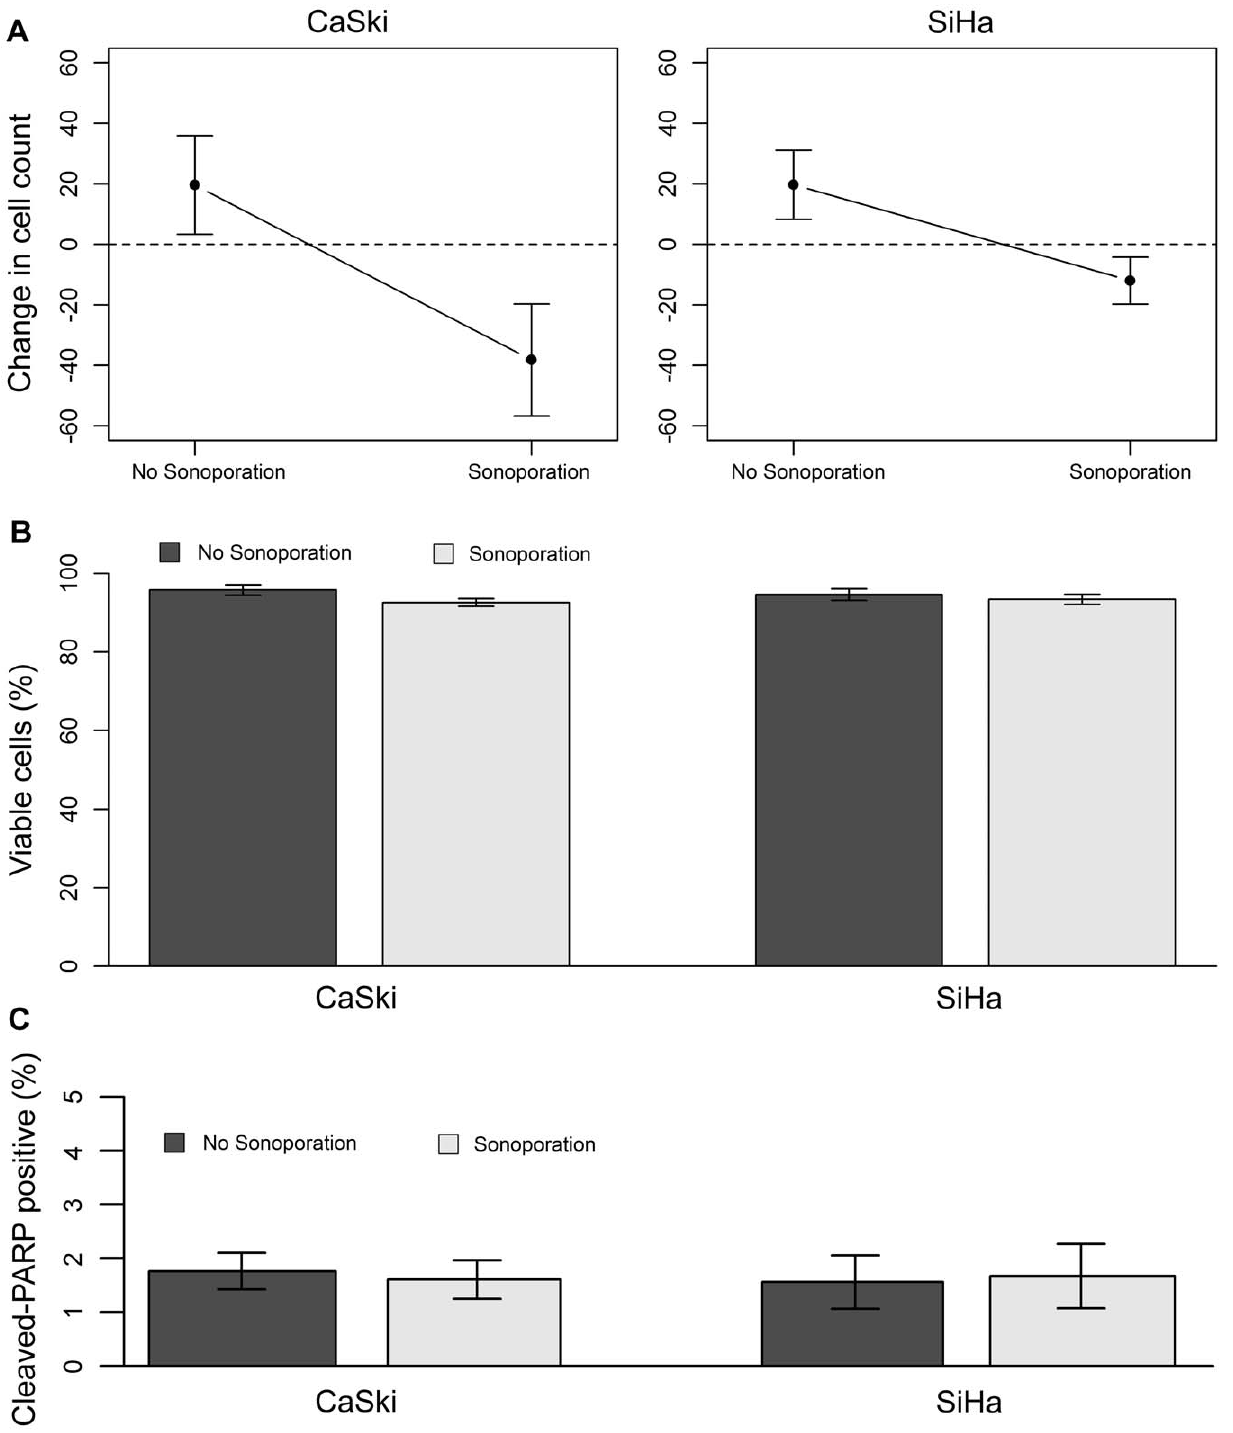
Figure 2. Effects of sonoporation on cell count, viability and apoptosis. (A) Change in cell count 2 hours following exposure of cells to sonoporation or sham no HIFU treatment. Sonoporation had a negative effect on cell count, ( P= 0.003, n= 10). Statistical analysis was performed using a two-way ANOVA with Student’s two-sample t-tests post hoc. (B) Viability of remaining cells 24 hours following exposure of cells to sonoporation or sham no HIFU treatment. Sonoporation did not diminish the viability of the remaining cells ( P . 0.05, n= 10). Statistical analysis was performed using a two-way ANOVA. (C) Percent early apoptotic cells, as evidenced by cleaved PARP staining, 24 hours following exposure of cells to sonoporation or sham no HIFU treatment. Sonoporation did not increase the number of apoptotic cells ( P . 0.05, n =6), as tested by a two-way ANOVA. Error bars represent mean + / 2 SEM.